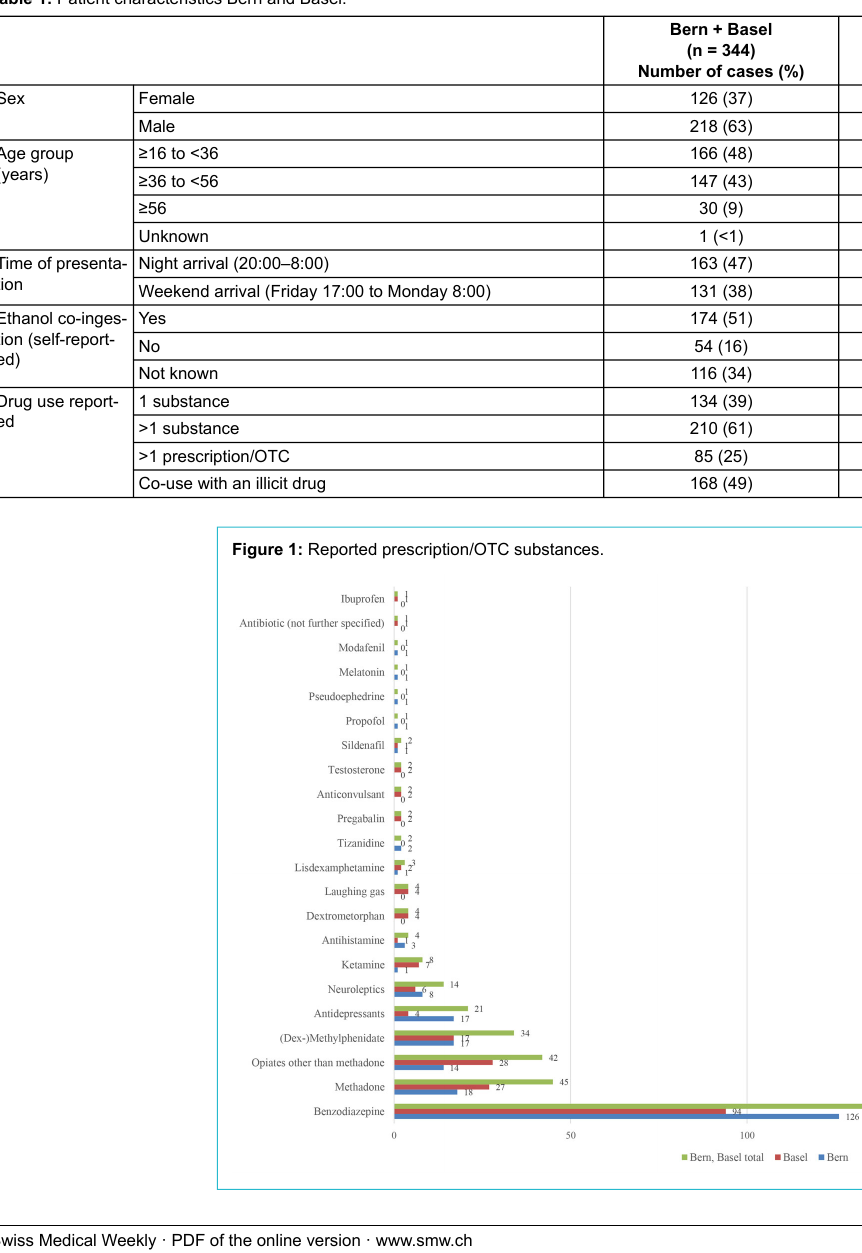
Table 1: Patient characteristics Bern and Basel.